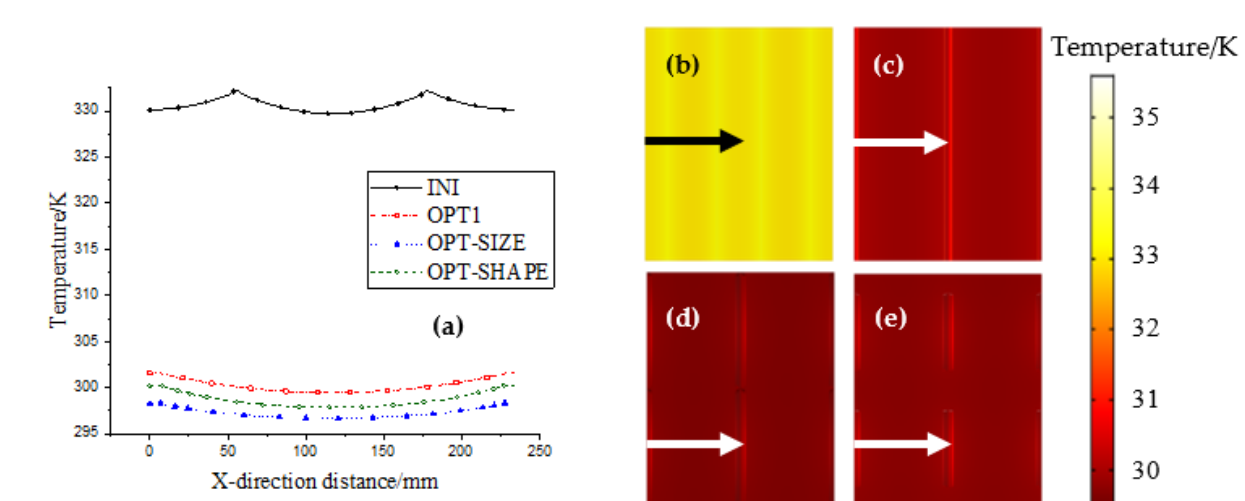
Figure 14. Maximum temperature evolution on ( a ) top surface and ( b ) bottom surface of the initial and optimized designs.